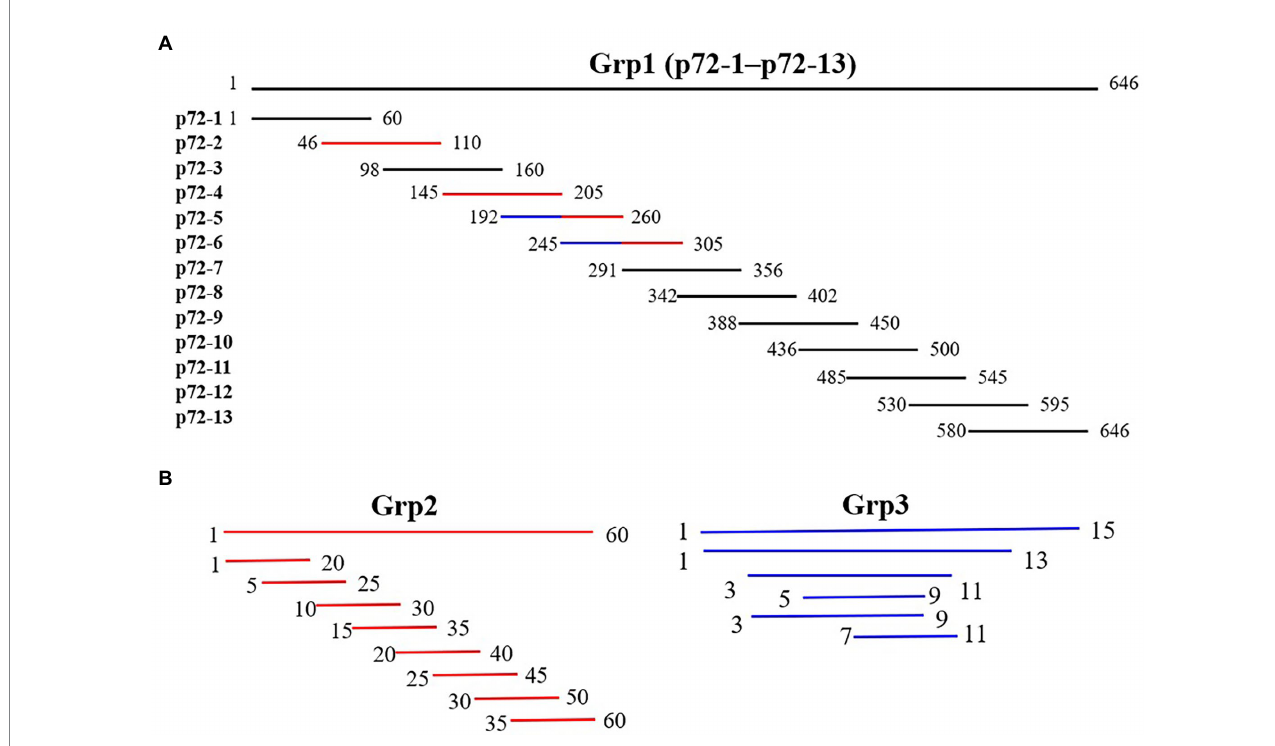
FIGURE 1 Diagram of overlapping fragments of p72. (A) Grp1 comprises 13 overlapping peptides (p72-1 to p72-13) based on full-length p72. (B) Grp2 (marked in red in Grp1) comprises the truncation mode of four peptides (p72-2, p72-4, p72-5, and p72-6). Grp3 (marked in the blue in Grp1) comprises the truncation mode of two overlapping peptides (p72-45, amino acids 192 to 205; p72-56, amino acids 245 to